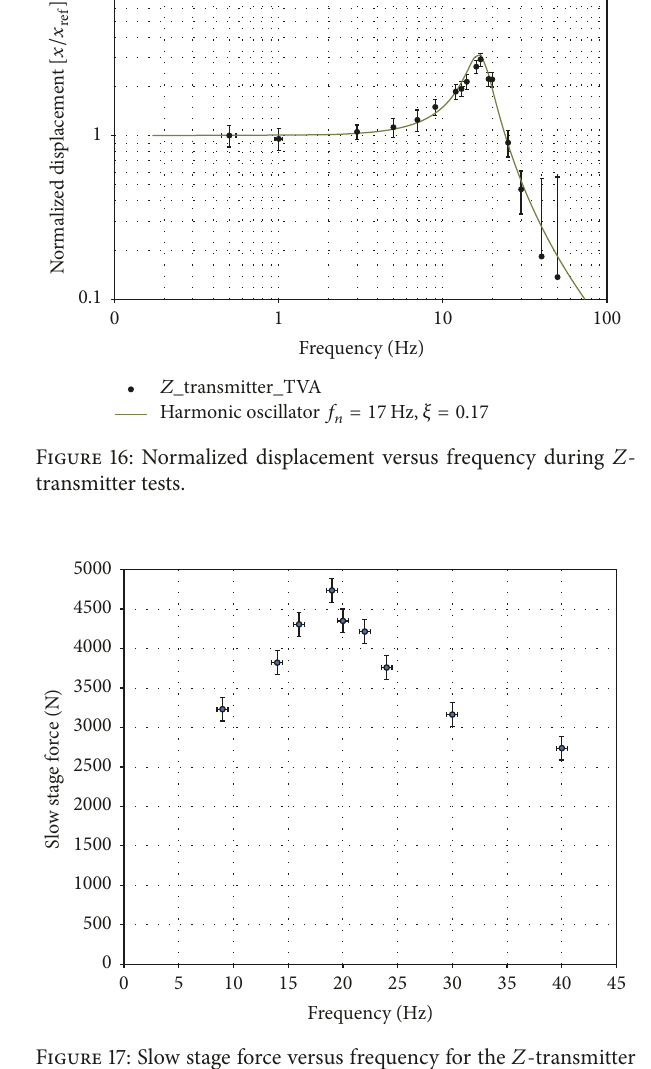
Figure 17: Slow stage force versus frequency for the 𝑍 -transmitter with 0.7 mm input